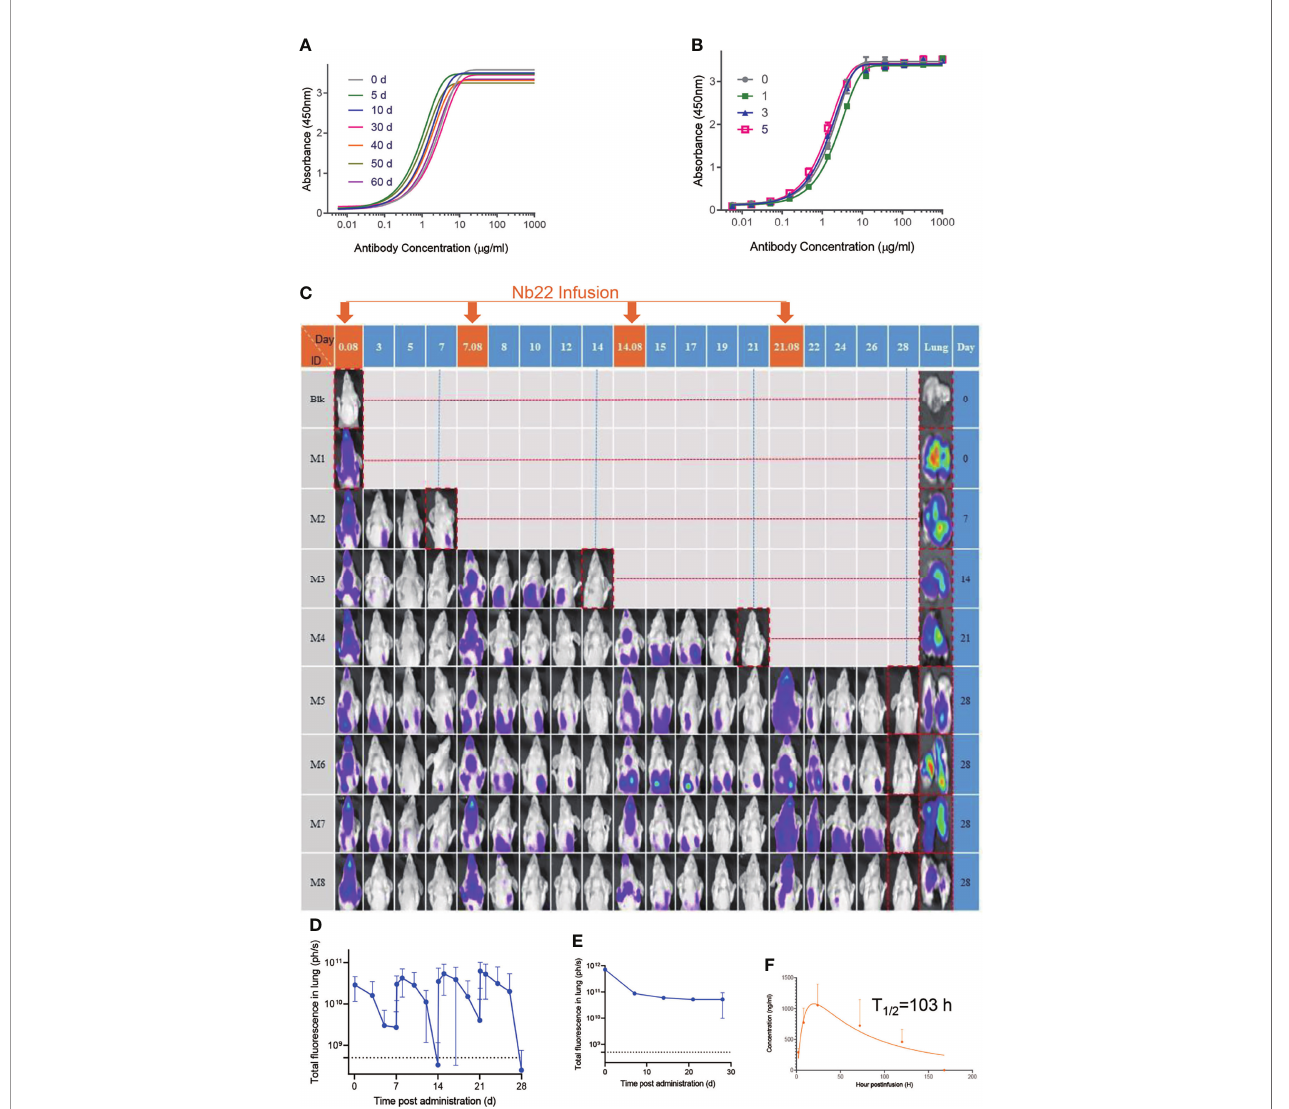
FIGURE 5 | Characterizing Nb22-Fc stability in vitro and pharmaceutics in vivo . (A) Binding curve of RBD with Nb22-Fc detected by ELISA after storage at room temperature in the indicated time points, namely, 0, 5, 10, 30, 40, 50, and 60 d. (B) Binding curve of RBD with Nb22 detected by ELISA after the indicated rounds of freeze-thawing, namely, 0, 1, 3, and 5 rounds, respectively. (C) Pharmacokinetic of Nb22-Fc labeled with dye YF ® 750 SE via intranasal administration was detected. Approximately 200 m g Nb22-YF750 was infused at days 0, 7, 14, and 21 respectively. The optical imaging of mice upper half body was measured by NightOwl LB 983 0.08 d (2 h) post Nb22-Fc infusion or at indicated time point labeled at the top of panel. The mice in the red dash line fi gure were sacri fi ced at the indicated time point in the left of panel for analysis of the fl uorescence intensity of lung. (D) The fl uorescence intensity of upper half body of mice in panel (C) was summarized. (E) The fl uorescence intensity of lung in lung column of (C) was summarized. (F) Bioavailability and t1/2 of Nb22 in BALB/c mice.Nb22 was intranasally (i.n.) administered into mice (n = 3, Female) at 200 m g (average of 10 mg/kg mice. Serum concentrations of the Nbs were determined at various time points by ELISA. T 1/2 , time of half-life. Data represent mean ±